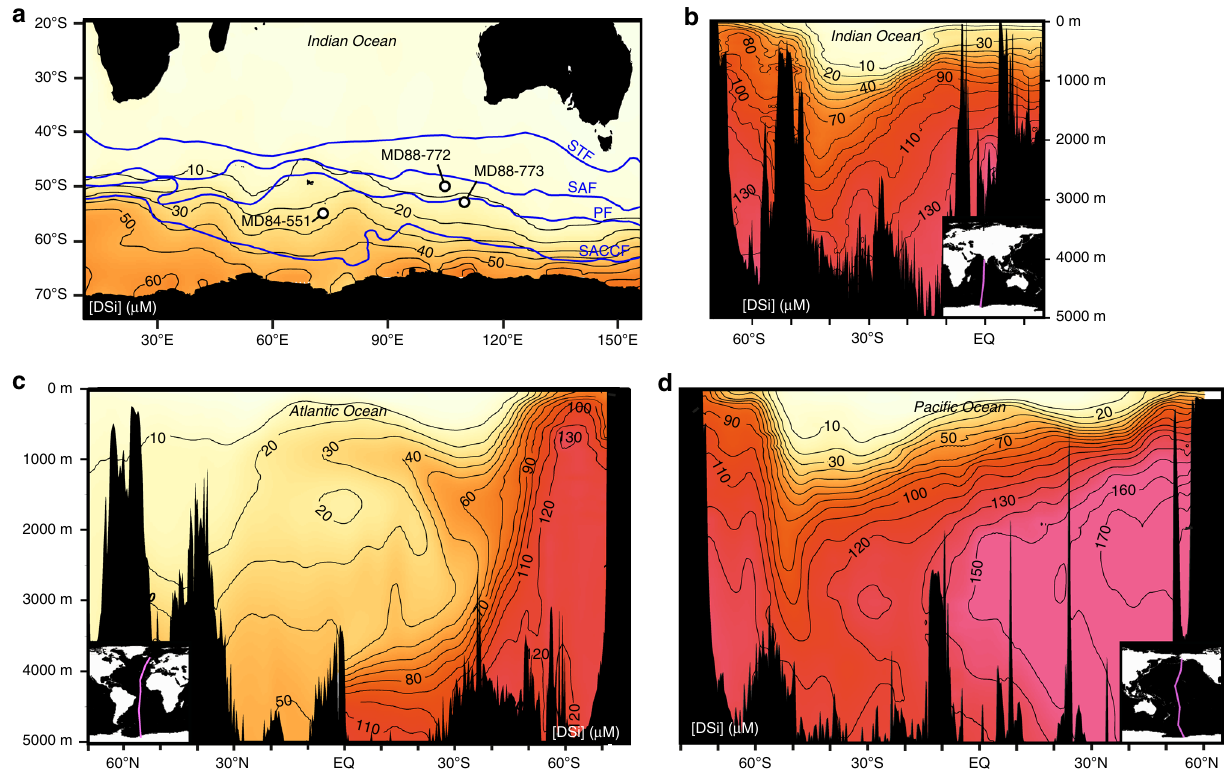
Fig. 1 The DSi distribution surrounding the core locations and within the major oceanic basins. a DSi concentrations in the surface ocean (10 m depth) across the Indian Sector. Front locations including the southern Antarctic circumpolar current front (SACCF), polar front (PF), Subantarctic front (SAF) and Subtropical front (STF) (blue lines) are according to Orsi et al. 92 MD84-551 and MD88-773 lie within the Antarctic Zone (AZ), the region of ocean south of the PF. MD88-772 lies in the Polar Frontal Zone (PFZ), which is delineated by the PF to the south and the SAF to the north. b – d Show pro fi les of [DSi] within the Indian, Atlantic and Paci fi c Oceans, respectively. Transect paths are given in within the inset of each panel. [DSi] data from the World Ocean Atlas 2013 93 , gridded using Ocean Data View 94